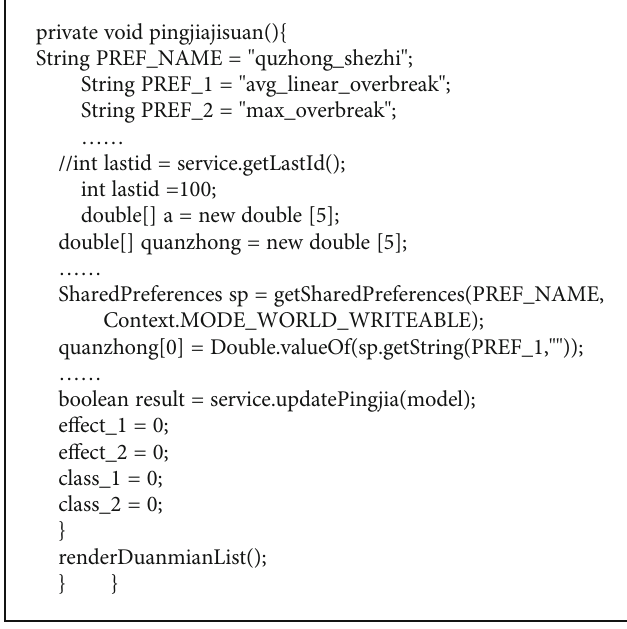
Pseudocode 1: Evaluation function